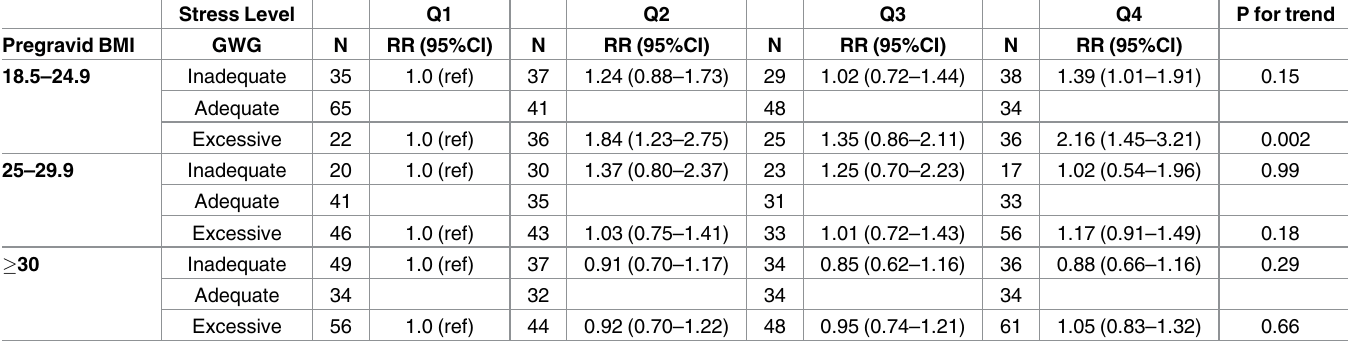
Table 3. Adjusted rate ratios from log multinomial regression estimating the association between perceived stresslevel and exceeding or being below the IOM recommendation for total GWG; Gestational Diabetes Effects’ on Mom